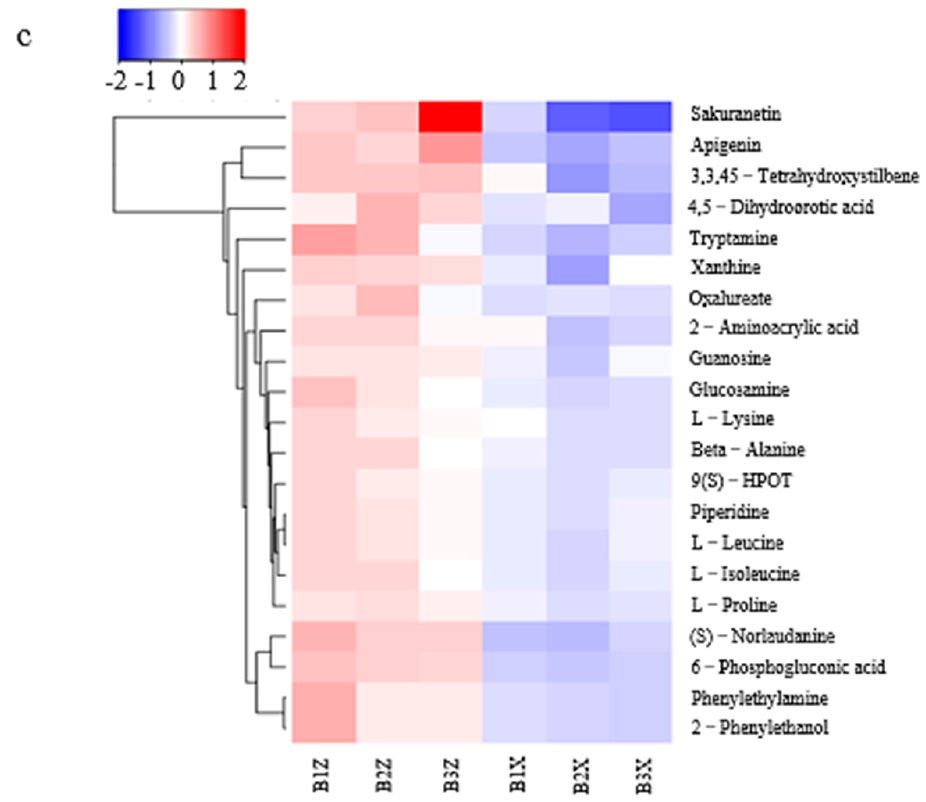
Figure 10. Heatmap analysis of di ff erent metabolites in four groups of litter. Clustering heat map of di ff erential metabolite analysis between litter groups of ( a ) original and plantation forest, ( b ) middle and lower layers of plantation forest, and ( c ) middle and lower layers of original forest.